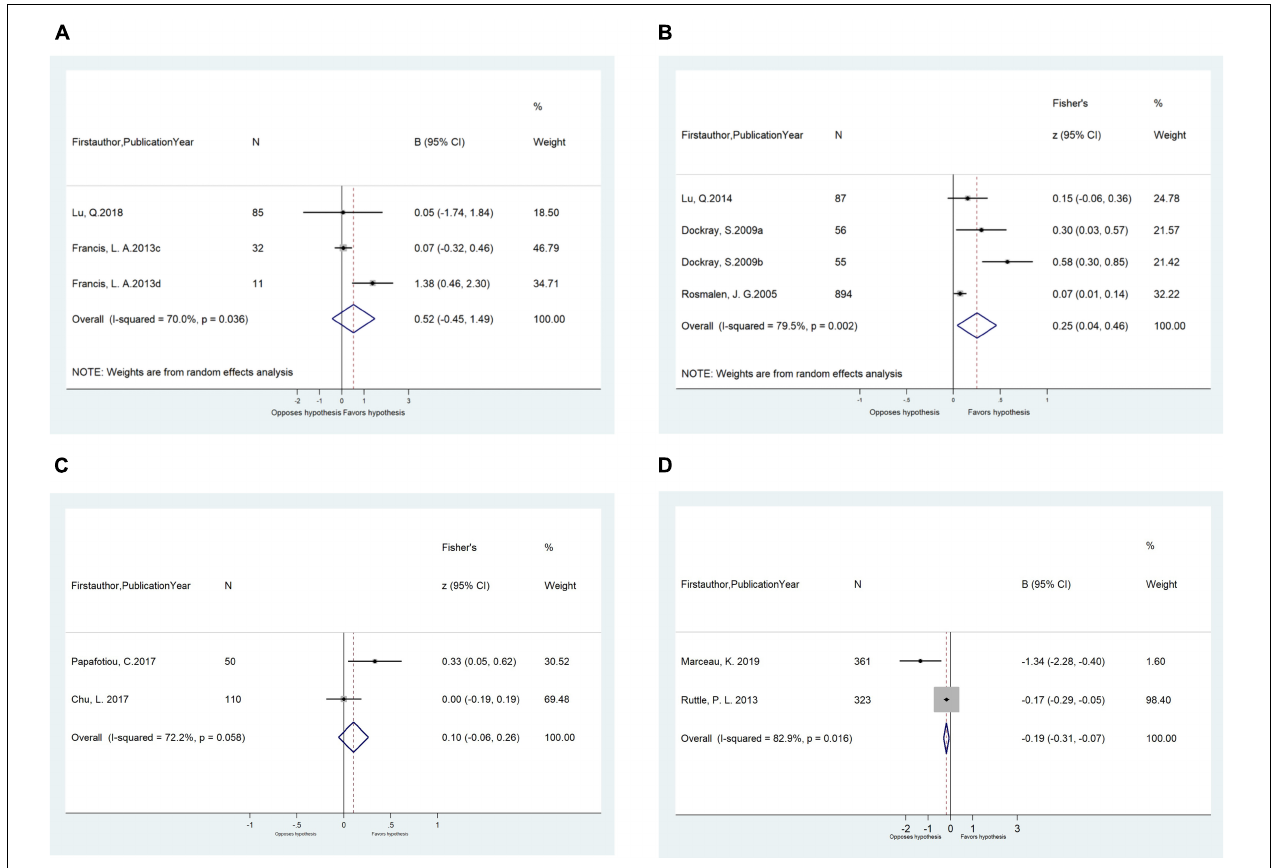
FIGURE 3 | (A) Meta-analysis of the associations ( β , 95% CI) between salivary cortisol (lnAUCi) and BMI z-score in cross-sectional studies ( n = 3). (B) Meta-analysis of the unadjusted correlations ( r , 95% CI) between salivary cortisol (log AUCi) and BMI in cross-sectional studies ( n = 4). (C) Meta-analysis of the unadjusted correlations ( r , 95% CI) between morning salivary cortisol and BMI/BMI z-score in cross-sectional studies ( n = 2). (D) Meta-analysis of the longitudinal adjusted effects ( β , 95% CI) of morning salivary cortisol on BMI in longitudinal studies ( n = 2). BMI, body mass